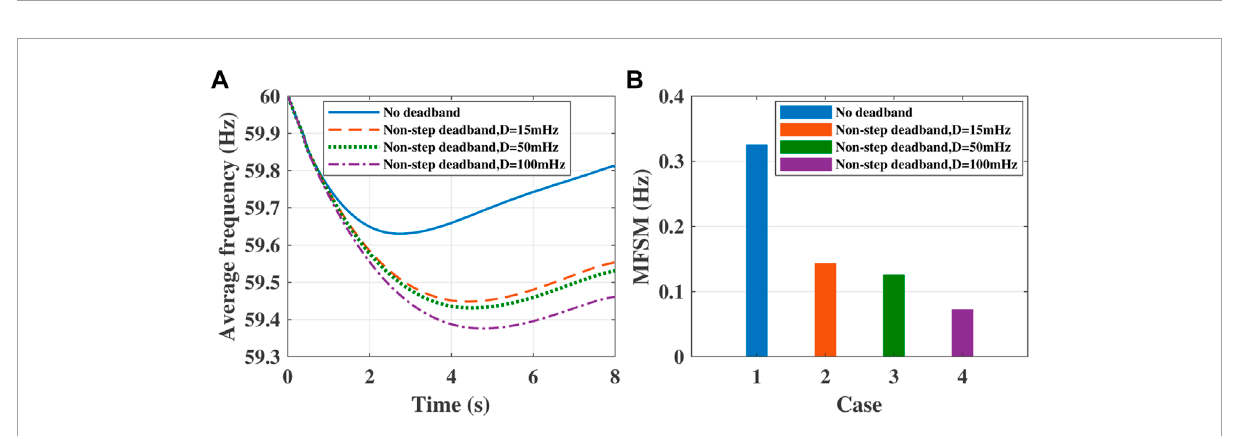
FIGURE 8 The effects of non-step deadbands on average frequency and